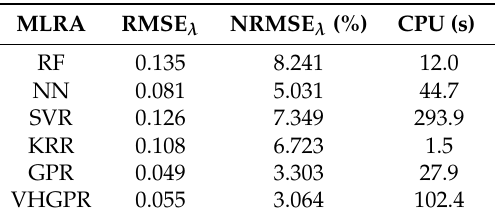
Figure 6. SCOPE NRMSE [%] results for the MLRAs validation for 30% of 500 SCOPE SIF spectra using 5 PCA conversion. Table 4. MLRA emulators validation results (RMSE λ , NRMSE λ ) and training and validation processing time (s: seconds) for 30% of 500 SCOPE SIF outputs and using 5 PCA